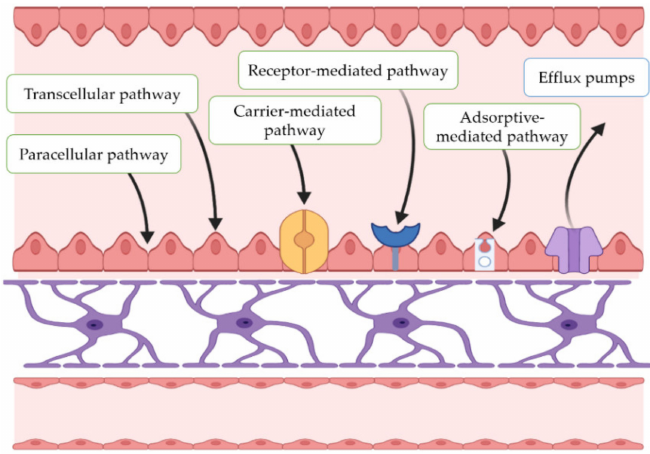
Figure 2. Possible pathways to cross the blood–brain barrier